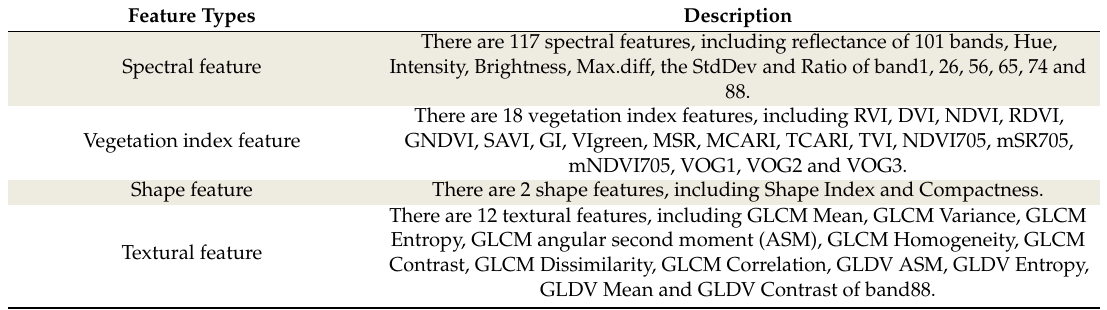
Table 2. Spectral, vegetation index, textural and shape features